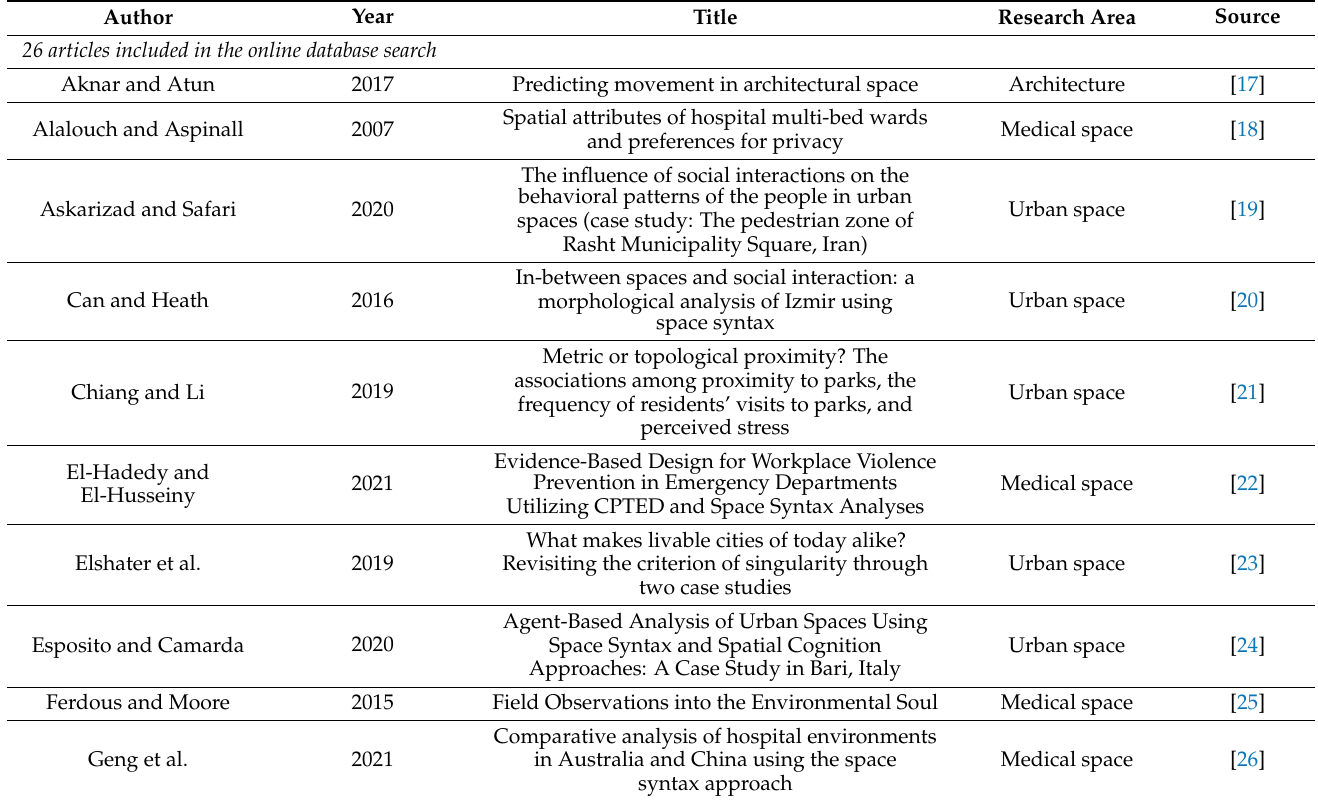
Table 1. Thirty-eight articles included in two rounds of data